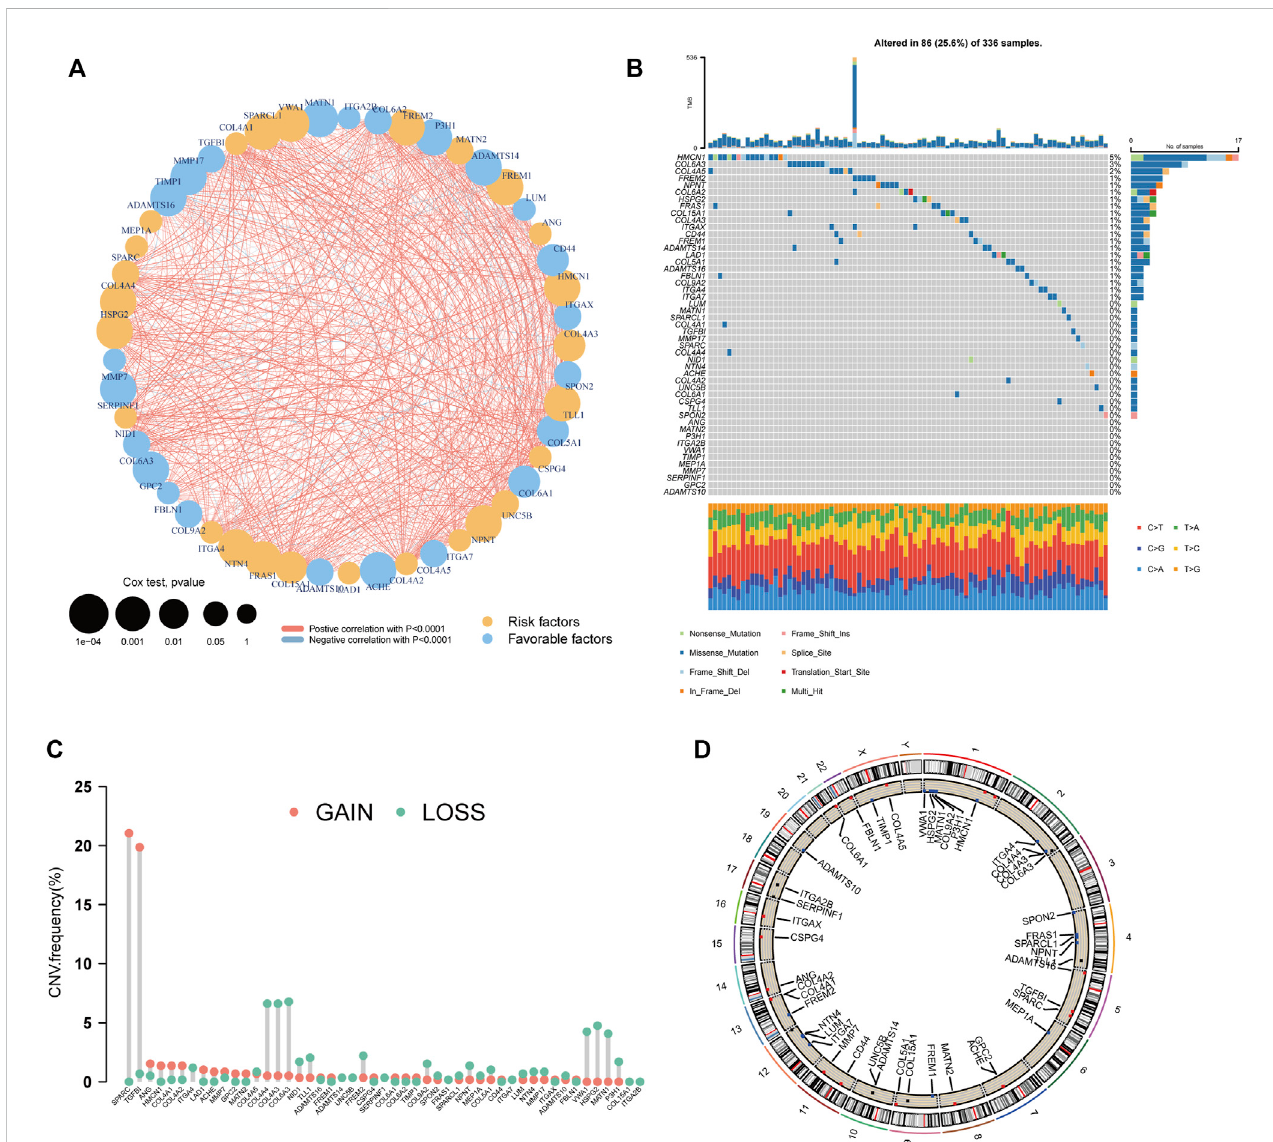
FIGURE 2 Genetic analyses of the BM-related genes. (A) The inter-relationship between each BM-related gene and the role of these genes in the prognosis of ccRCC. (B) The waterfall plot depicting the mutation of the prognostic BM genes. (C) The CNV frequency of the prognostic BM genes. (D) The distribution of the prognostic BM genes in each chromosome with CNV gain colored red, CNV loss colored blue and no CNV colored